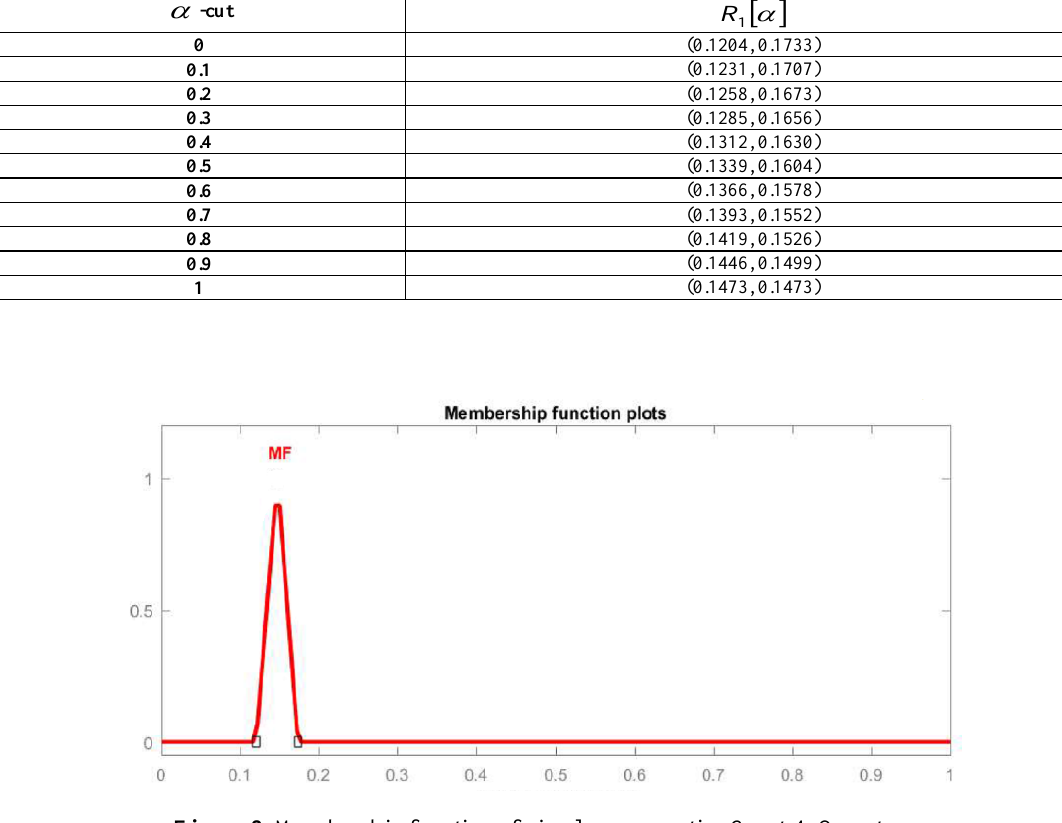
Figure 8. Membership function of circular consecutive 2-out-4: G